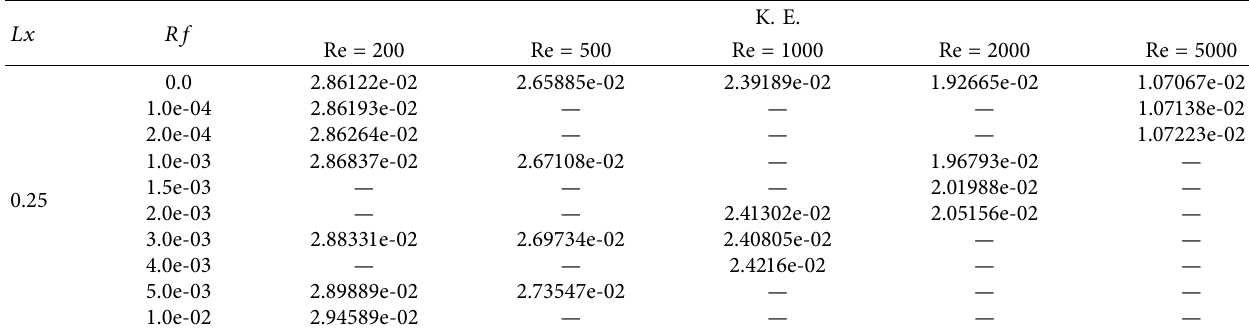
Table 4: Kinetic energy values for varying values of the fluid relaxation